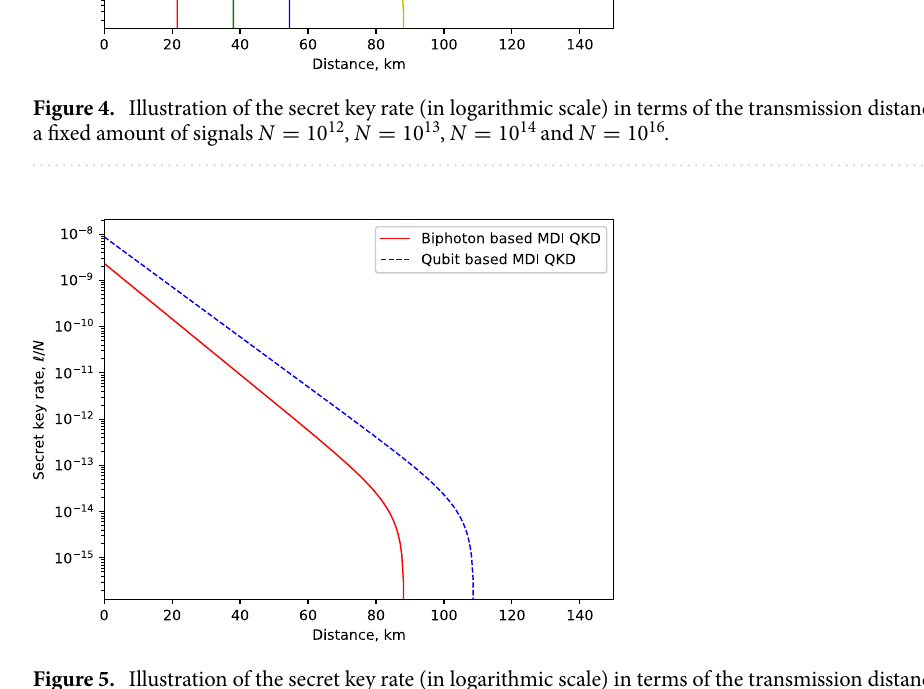
Figure 5. Illustration of the secret key rate (in logarithmic scale) in terms of the transmission distance (km) for our proposed biphoton MDI-QKD and the qubit-based MDI-QKD proposed in Ref. 55 for a fixed amount of 10 16 . signals N =